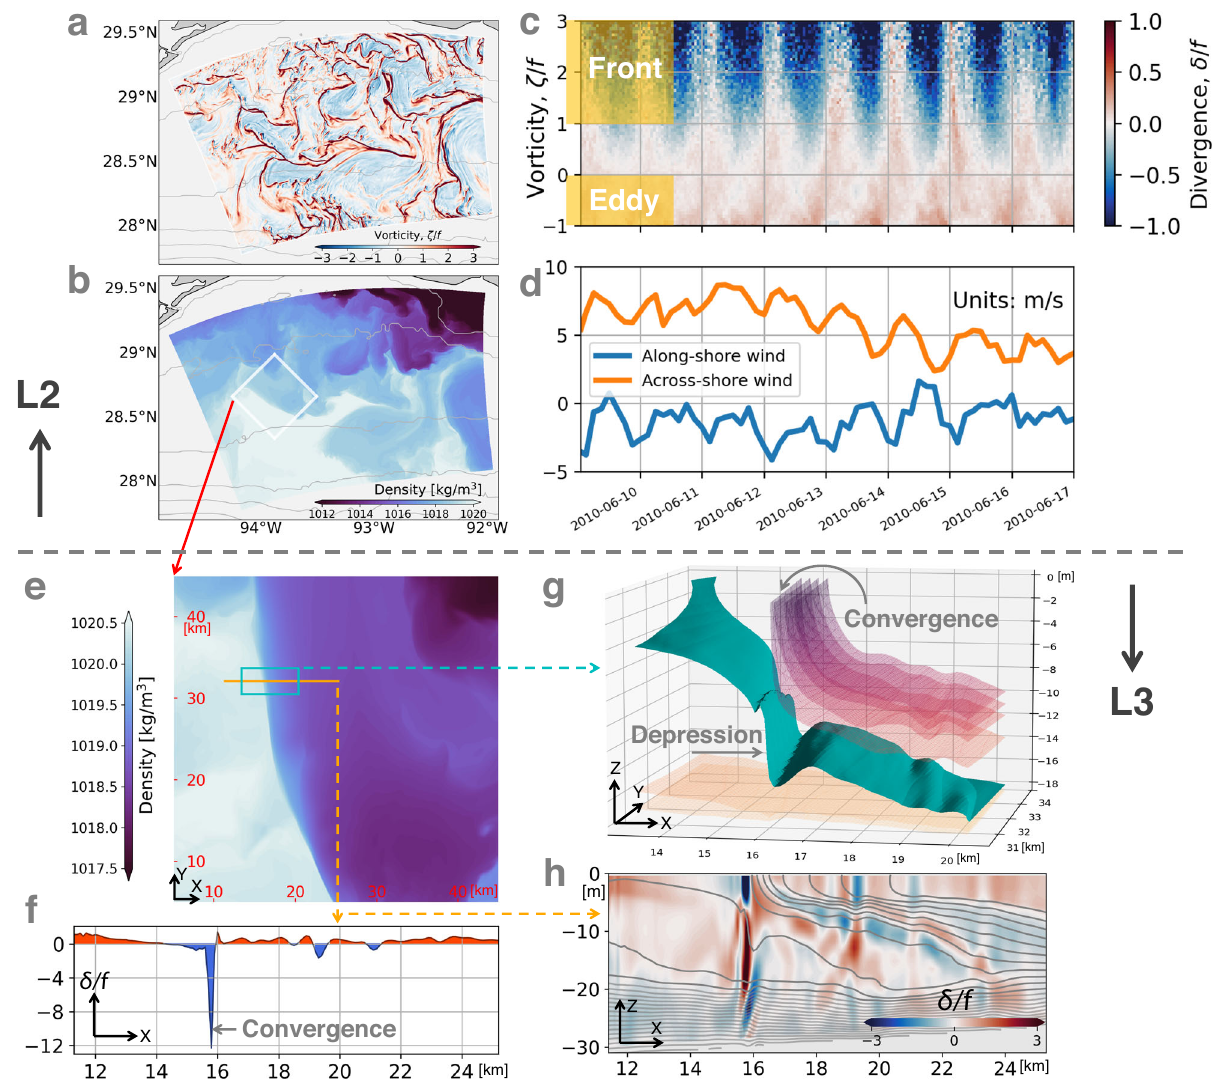
Fig.3|Diurnalconvergenceatfronts.a Surfacenormalizedrelativevorticity( ζ / f ), where ζ = ∂ v / ∂ x −∂ u / ∂ y . b Surface density. Isobaths are contoured in gray. The whiteboxdenotestheL3domain. c Surfacenormalizeddivergence( δ / f )binnedasa function of ζ / f and time. The statistics are calculated over the L2 domain. d Time series ofland-seabreeze. The wind speed is spatially averaged overthe L2domain. e Zoomed in view of surface density over the L3 domain. f Surface normalized